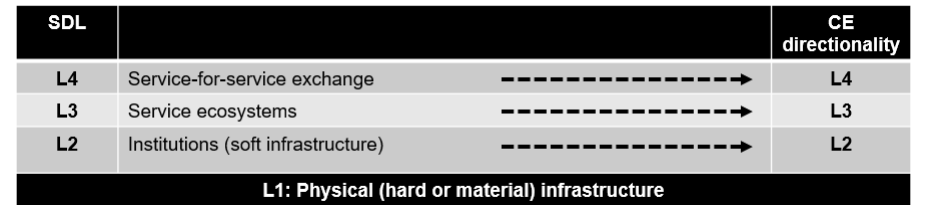
Fig. 5 . The relationship between the two paradigms in the integrated model. Source: Author’s